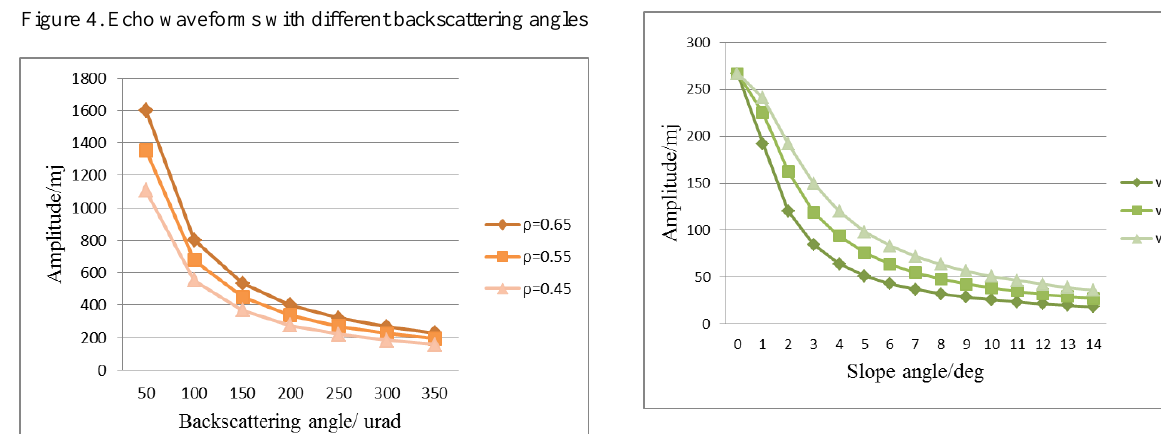
Figure 7. The change of amplitude in different conditions